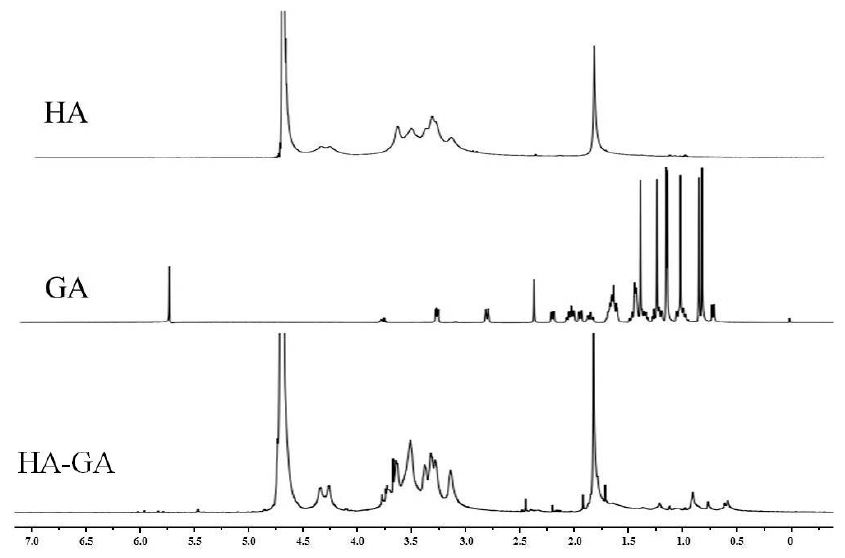
Figure 2. 1 H-NMR spectra of HA, GA, and the HA–GA conjugate. Figure 2. 1 H - NMR spectra of HA, GA, and the HA–GA conjugate. Figure 2. 1 H - NMR spectra of HA, GA, and the HA–GA conjugate.